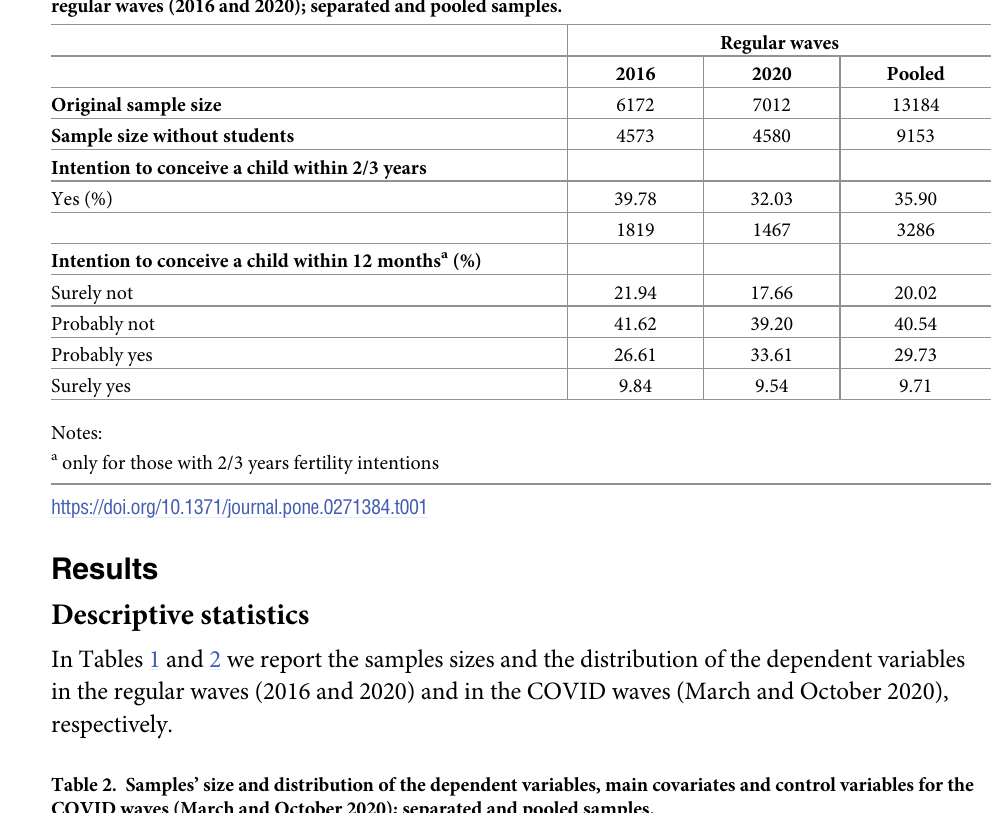
Table 1. Samples’ size and distribution of the dependent variables, main covariates and control variables for the regular waves (2016 and 2020); separated and pooled samples.